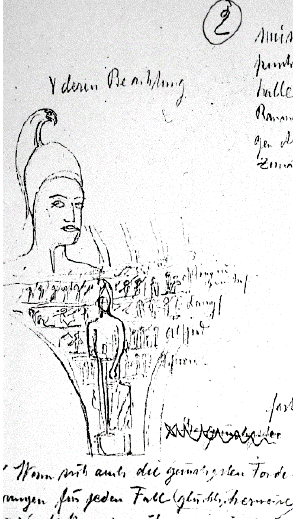
Figure 11. A sketch for the interior decoration of the Centennial Hall (Deutsches Museum in Munich).